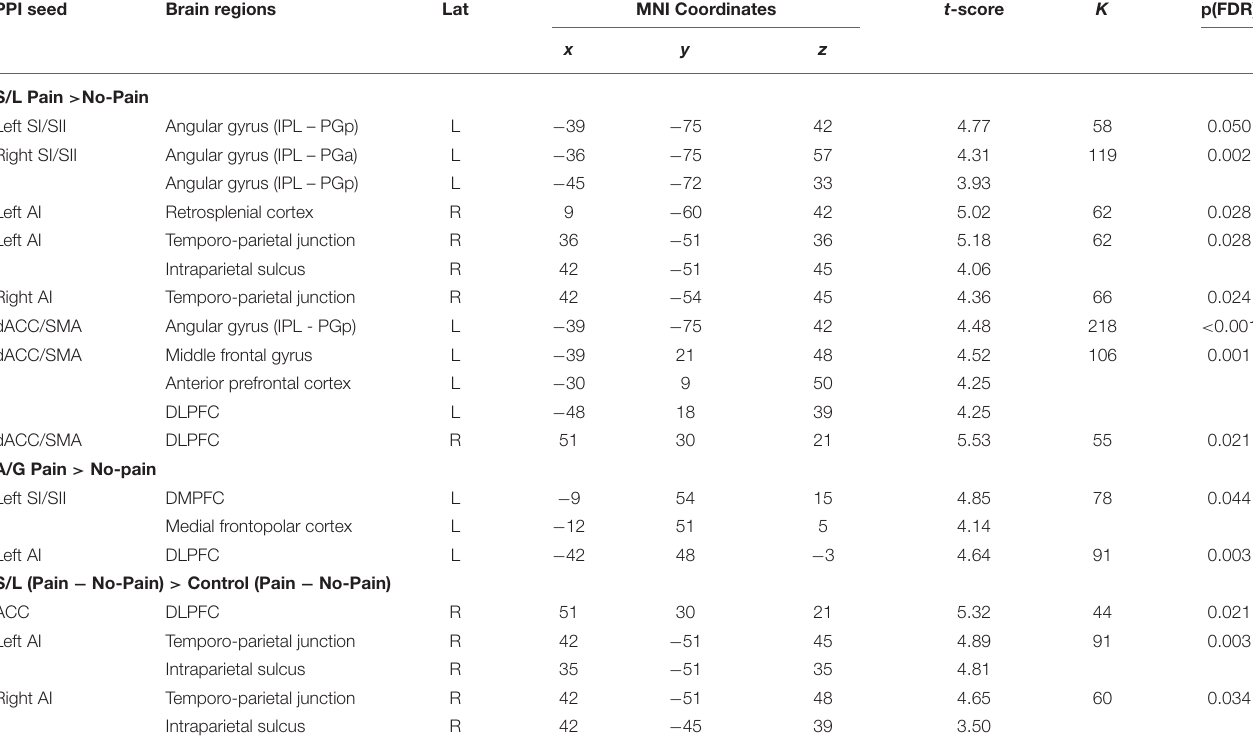
TABLE 4 | Regions showing significant PPI effects for within group contrasts for at the whole group level and for each pain responder group. PPI seed Brain regions Lat MNI